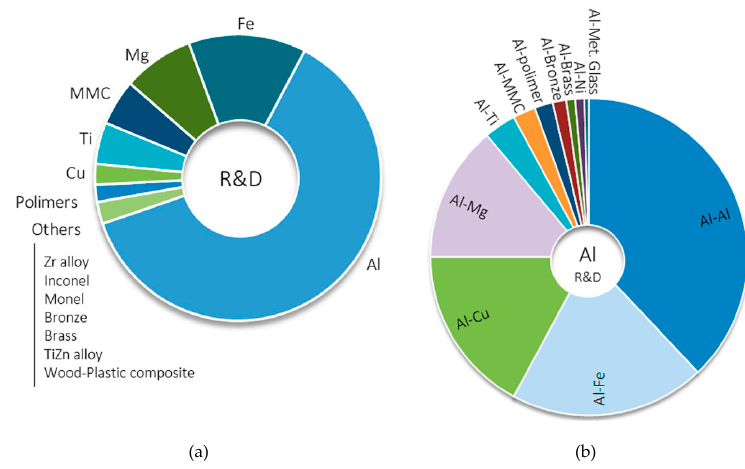
Figure 3. Papers on FSW: (a) same material joints and (b) dissimilar materials joints, reproduced from [12], with permission from Taylor & Francis,